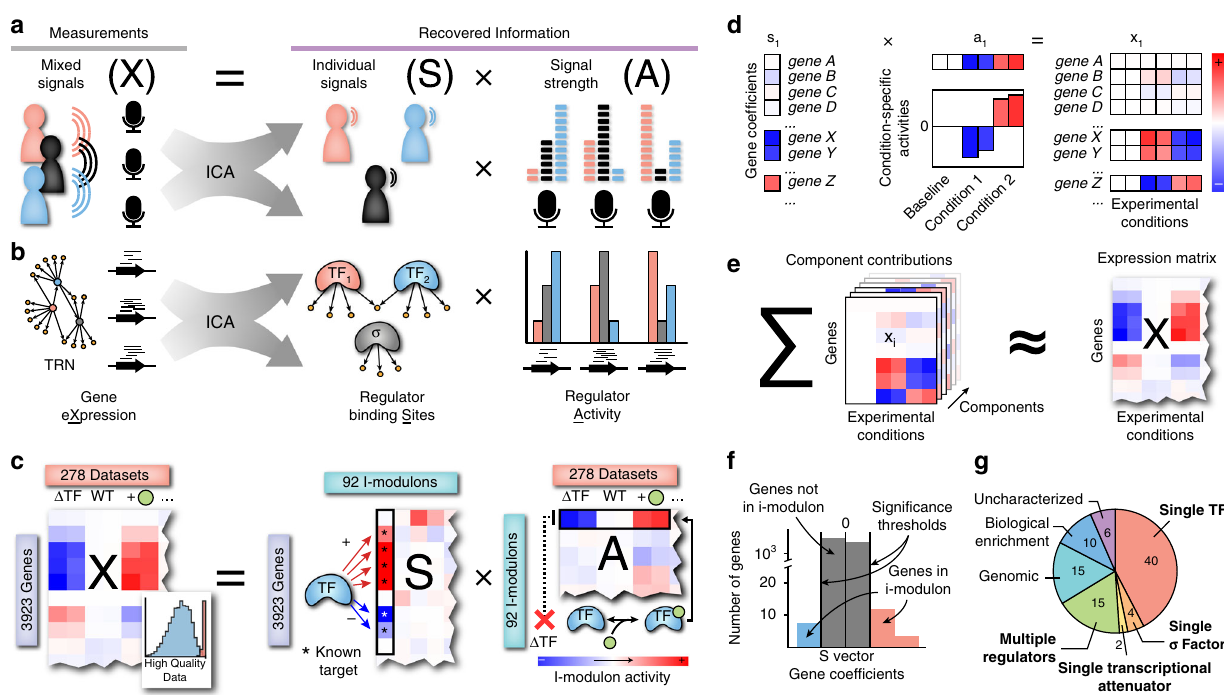
Fig. 1 ICA extracts regulatory signals from expression data. a Given three microphones recording three people speaking simultaneously, each microphone records each voice (i.e. signal) at different volumes (i.e. signal strengths) based on their relative distances. Using only these measured mixed signals, ICA recovers the original signals and their relative signal strengths by maximizing the statistical independence of the recovered signals 13,71 . The mixed signals ( X ) are a linear combination of the matrix of recovered source signals ( S ) and the mixing matrix ( A ) that represents the relative strength of each source signal in the mixed output signals. This relationship is mathematically described as X = SA . b An expression pro fi le under a speci fi c condition can be likened to a microphone in a cell, measuring the combined effects of all transcriptional regulators. c Schematic illustration of ICA applied to a gene expression compendium. See Supplementary Fig. 1a, b for additional details on data quality. The example TF is a dual regulator that primarily upregulates genes, and is activated by the green circular metabolite. Example experimental conditions shown are a TF knock-out, wild-type, and wild-type grown on medium supplemented with the activating metabolite. Each column of X contains an individual expression pro fi le across 3923 genes in E. coli . d Each component (column of S ) contains a coef fi cient for each gene. These coef fi cients are scaled by the component ’ s condition-speci fi c activities (row in A ) to form the component ’ s contribution to the transcriptomic compendium e . The sum of the contributions from the 92 components reconstructs most of the variance in the original compendium. f Independent components are converted into i-modulons by removing all genes with coef fi cients within a signi fi cance threshold (indicated in gray). Signi fi cant genes may have either positive (red) or negative (blue) coef fi cients. g Distribution of i-modulon categories. Categories of regulatory i-modulons are labeled in bold font. Genomic i-modulons account for single gene knock-outs, large deletions or duplications of genomic regions. Biological i-modulons contain genes enriched for a speci fi c function, but are not linked to a speci fi c transcriptional regulator. For more information, see Supplementary Fig. 1 and Supplementary Table